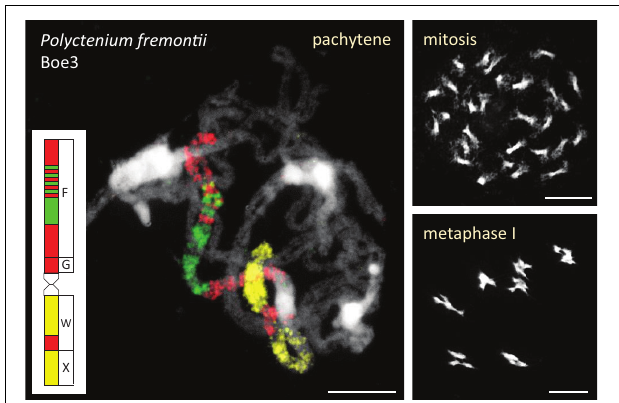
FIGURE 5 | Quadrivalents in Polyctenium fremontii (2 n = 4 x = 28). The 28 chromosomes form seven quadrivalents during the first meiotic division. The quadrivalent of Boe3 homeologs was identified by CCP of pachytene chromosomes with BAC contigs specific for genomic blocks F, G, W, and X ( Supplementary Table S3 ). Chromosomes were counterstained by DAPI. Scale bars, 10 µ m.